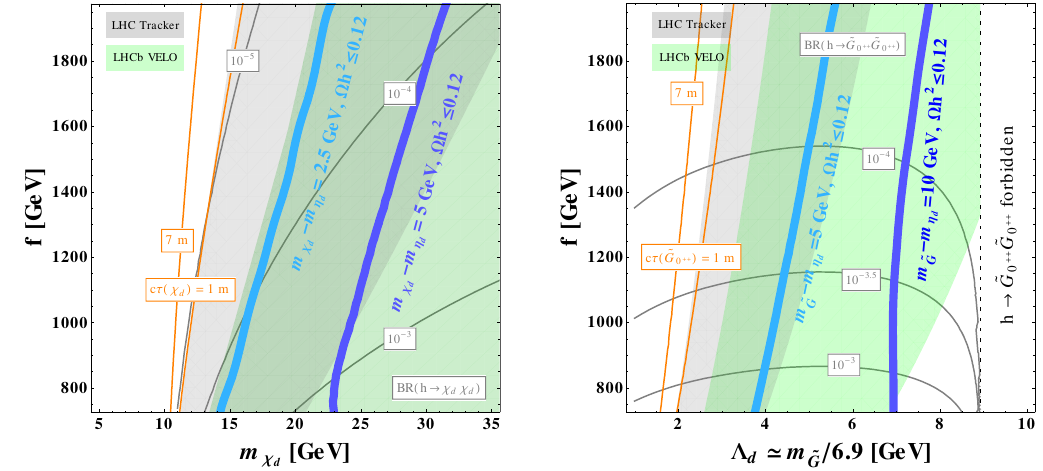
2 bound on scalar hadron lifetimes. DM h (right), and the scalar 0 ++ 2 e G ) is 0 ++ ! , and the decay into q d (cid:22) q d 0 ++